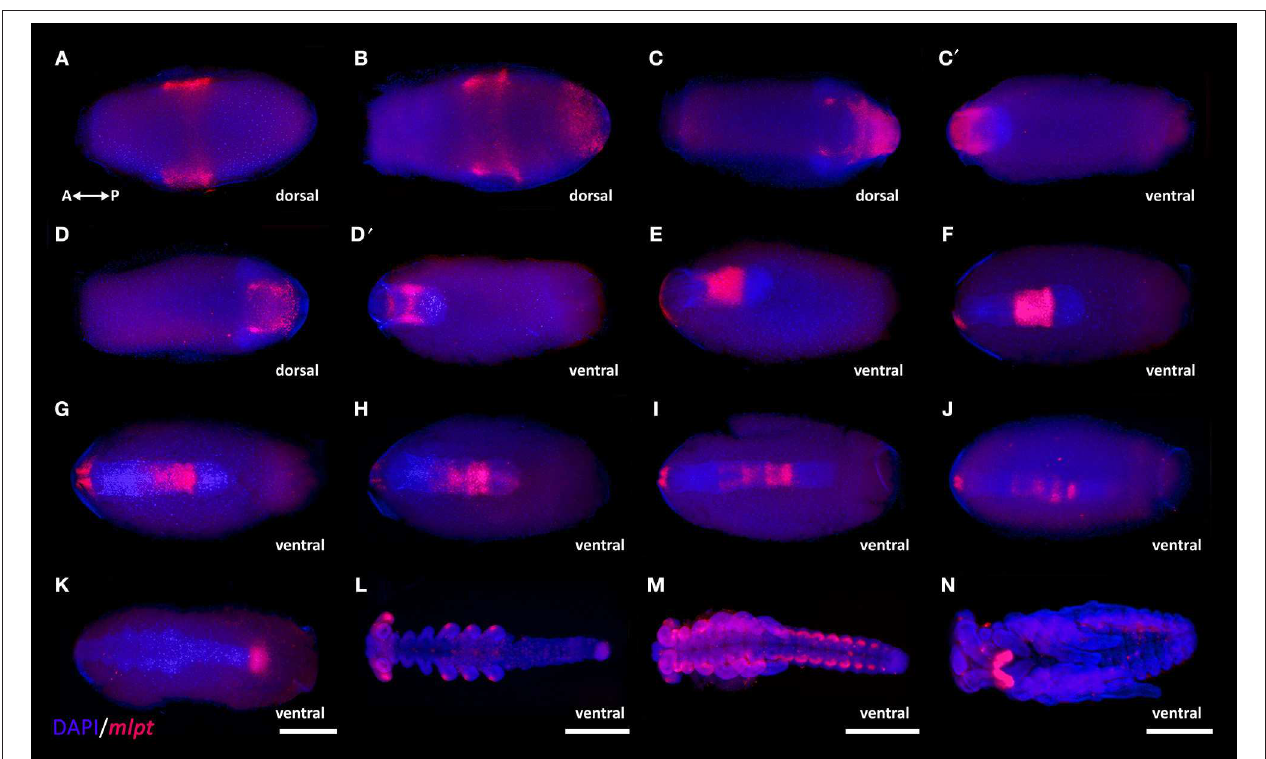
FIGURE 3 | mlpt expression during R. prolixus embryogenesis. Anterior of the egg to the left in all panels. During the processes of anatrepis and katatrepsis embryo orientation shifts along the AP and DV axis (see Nunes-da-Fonseca et al., 2017 and Berni et al., 2014 for details). mlpt expression is displayed in false-colored red and DAPI in blue. Ventral egg view (A,B,C ′ ,D ′ ,G,H,I) . Eggs dissected from the yolk (L,M,N) (A) Stage 1B, ∼ 10h after egg laying (AEL) mlpt expression is detected as a broad middle-anterior domain, which overlaps with to the future head. (B) A few hours later (stage 2A- 12–18h AEL) besides the anterior domain, a posterior domain is also observed. (C,C ′ ,D,D ′ ) At stage 3A (24–30h AEL) during anatrepsis, the posterior expression domain is at the surface (ectoderm) but does not extend toward the posterior region of the germ band. (E–J) At stage 3B (30–36h AEL) the expression remains anterior to the posterior region and in a small bilateral domain in the head and starts to fade as elongation is finished. (K) Stage 4 (36–48h) at beginning of head and thoracic segmentation, expression is observed at the posterior tip. (L) Stage 5 (48–60h AEL) during leg growth a staining is specifically observed at the tips of the legs and in the head lobes. (M) At stage 7 (72–84h AEL) abdominal segmentation is evident and expression is observed at lateral segmental cell clusters potentially corresponding to peripheral neurons as previously suggested for T. castaneum ( Savard et al., 2006). (N) Stage 9 (96–108h AEL) during germ band retraction expression is restricted to the antennae. R. prolixus embryonic staging system was described in Berni et al.